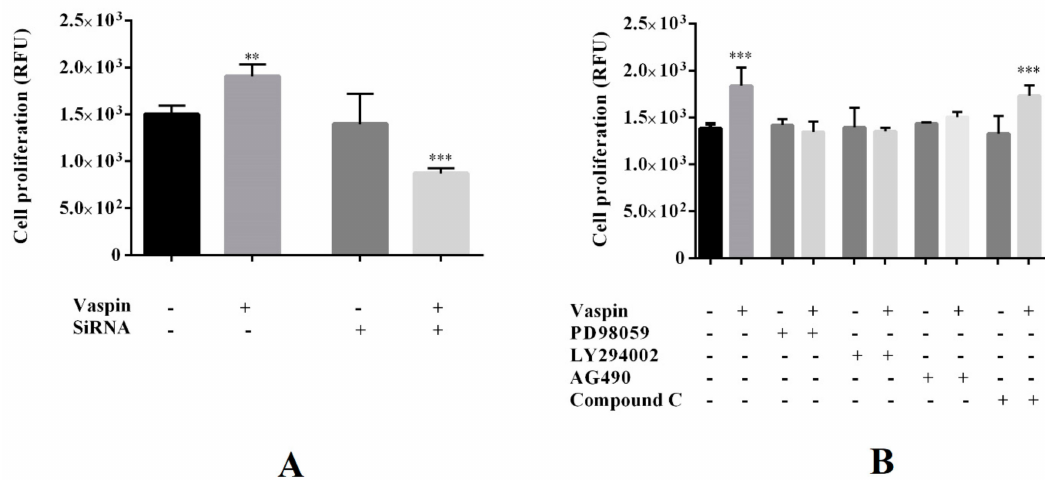
Figure 3. Involvement of glucose-regulated protein (GRP78) receptor ( A ) and mitogen-activated kinase (MAP3 / 1 / ERK1 / 2), Janus kinase (STAT3) and protein kinase B (AKT) and 5 (cid:48) AMP-activated protein kinase (AMPK, know like PRKAA1) kinases ( B ) on vaspin-mediated induction of granulosa (Gc) proliferation: Gc were seeded in 96-well culture plates in M199 medium at a concentration of 5 × 10 4 viable cells per well. Cells were pretreated with GRP78 siRNA (2 nM) for 24 h or for 1 h with the following MAP3 / 1, AKT, STAT3, and PRKAA1 kinases inhibitors: PD098059 (5 µ M), LY294002 (10 µ M), AG490 (50 µ M), and Compound C (1 µ M). Afterward, vaspin (1 ng / mL) was added for 24 h and cell proliferation was analysed using an alamarBlue assay. Experiments were independently performed and repeated five times ( n = 5). The data are plotted as mean ± SEM. Significance between control and vaspin or inhibitors and vaspin + inhibitors treatments are indicated by ** p < 0.01 and *** p < 0.001; Control (C), Relative Fluorescence Unit (RFU).